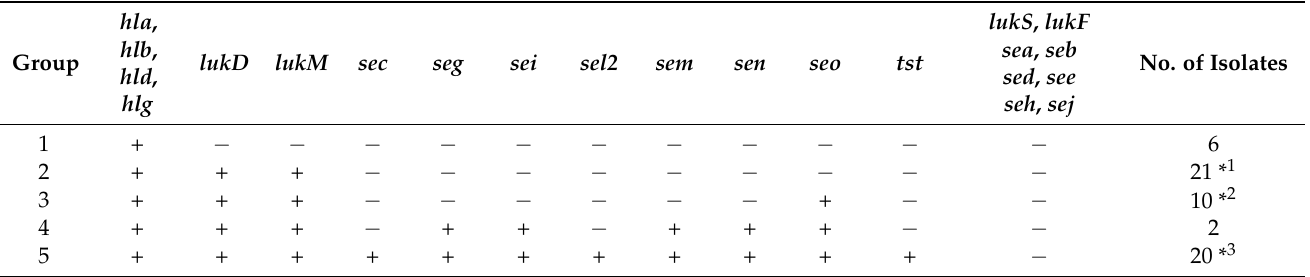
Table 3. Profiles of PCR analysis for leukocidines, haemolysisns, and superantigenic